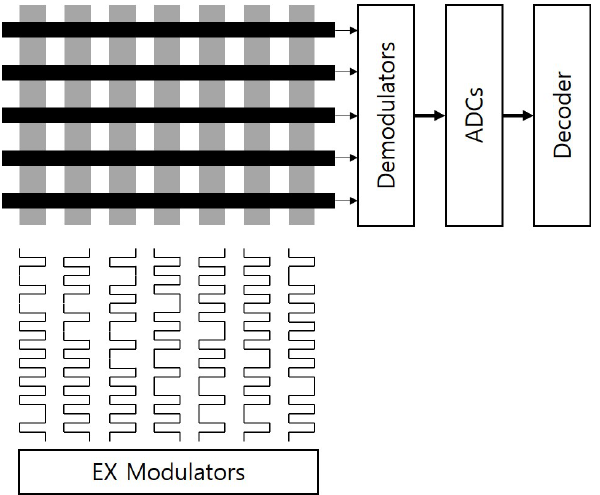
Figure 12. Code division multiple sensing. CDMS enables the multiple capacitance sensing at the same time by transmitting orthogonal codes through multiple EX lines. The charge amplifiers’ outputs are demodulated and converted into digital data that are decoded as multiple simultaneous touch